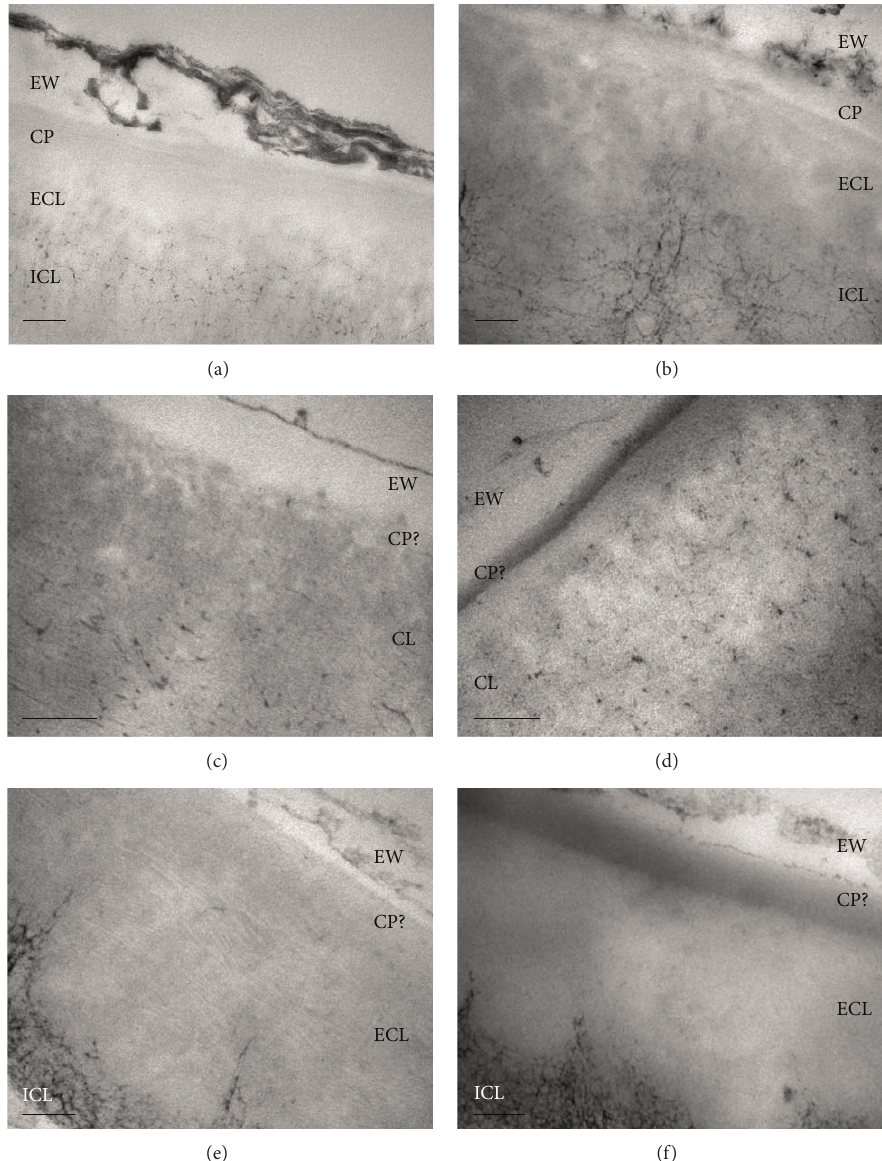
Figure 3: Ultrastructure and cuticular layers of eucalypt, poplar, and pear cuticles embedded in Spurr’s (a, c, and e) and LR-White resin (b, d, and f). EW: epicuticular waxes, CP: cuticle proper, CL: cuticular layer, ECL: external cuticular layer, and ICL: internal cuticular layer. Bars: 200